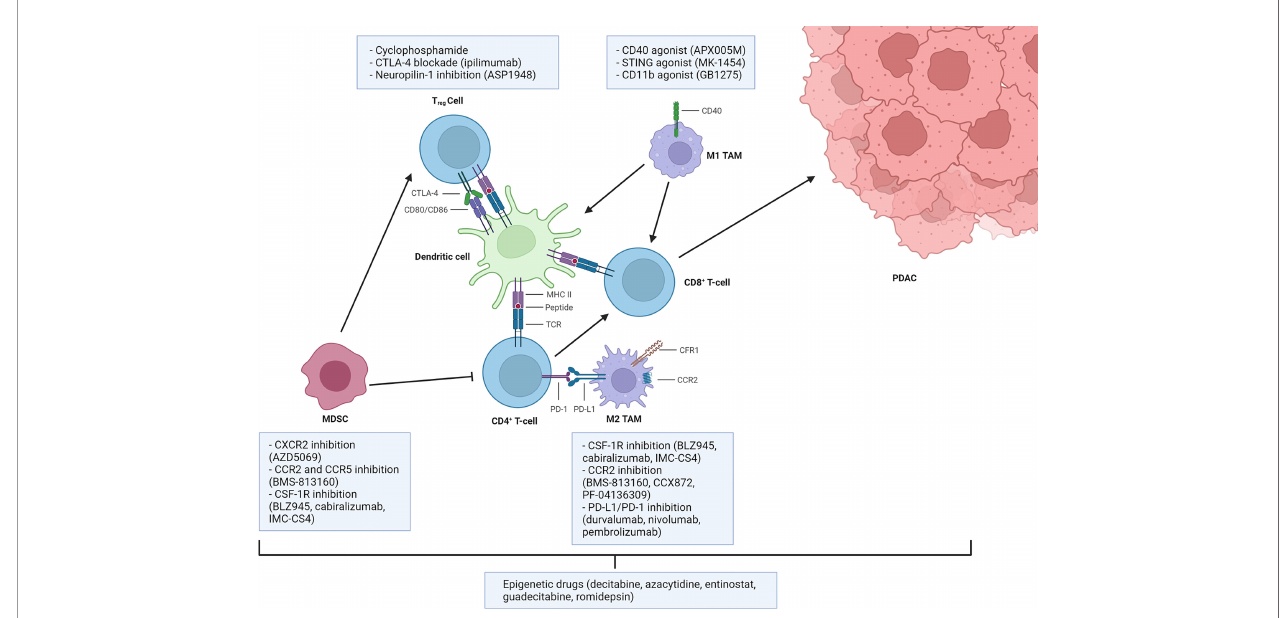
FIGURE 2 | Main strategies to overcome myeloid and Treg-mediated immunosuppression. Dendritic cells or in fl ammatory macrophages (TAMs M1) sustain the antitumor immune response through antigen presentation. Myeloid-derived suppressor cells (MDSCs), anti-in fl ammatory tumor-associated macrophages (TAMs M2), and regulatory T (Treg) cells regulate these processes by exploiting inhibitory pathways, thus establishing an immunosuppressive tumor microenvironment. Some of the most clinically relevant therapeutic strategies available to target those pathways are reported. Created with